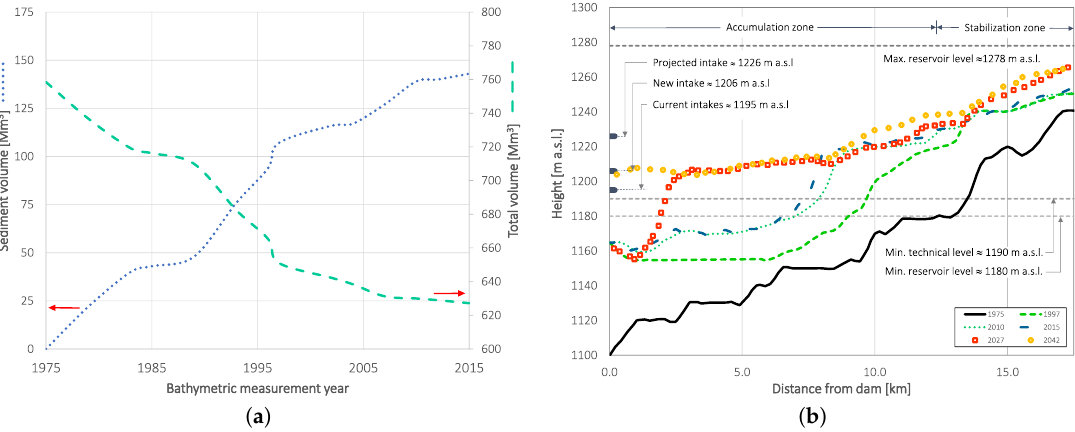
Figure 2. Sediment evolution of La Esmeralda reservoir, 1975–2015. ( a ) Sediment and total volume and ( b ) bathymetric measurement and